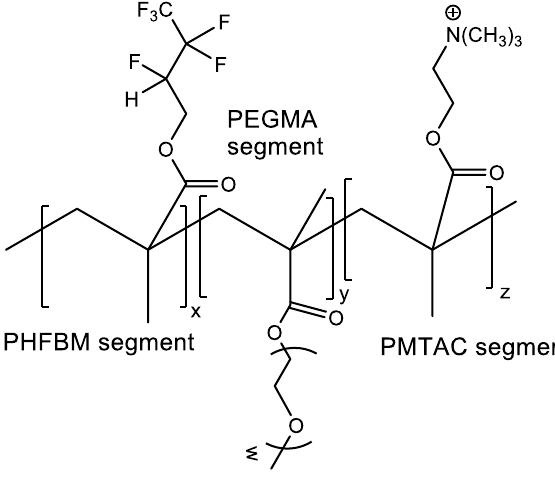
Figure 8. Amphiphilic block-like copolymer membrane surface modifier for the creation of an integrated active-passive fouling release nanocoating.